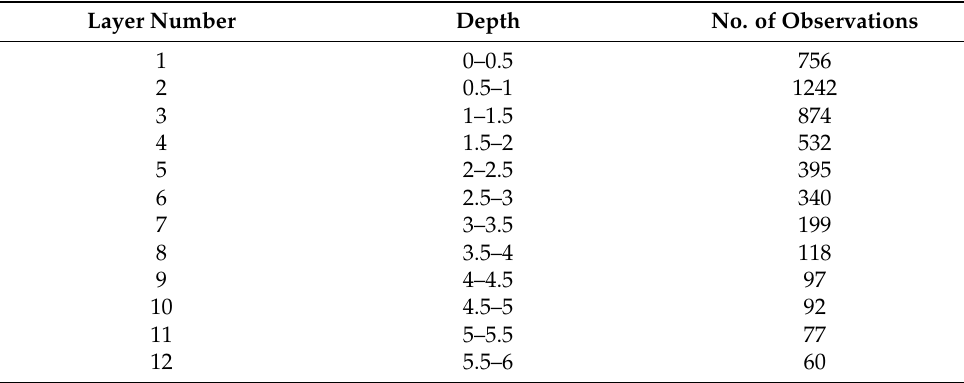
Table 2. No. of observations with the depth.